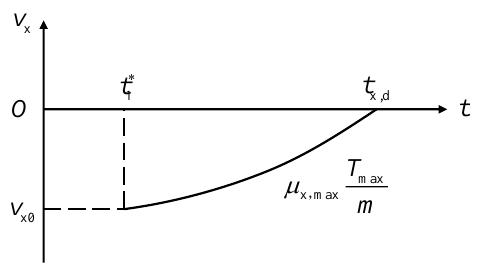
Figure 5. Schematic diagram of t x,d .